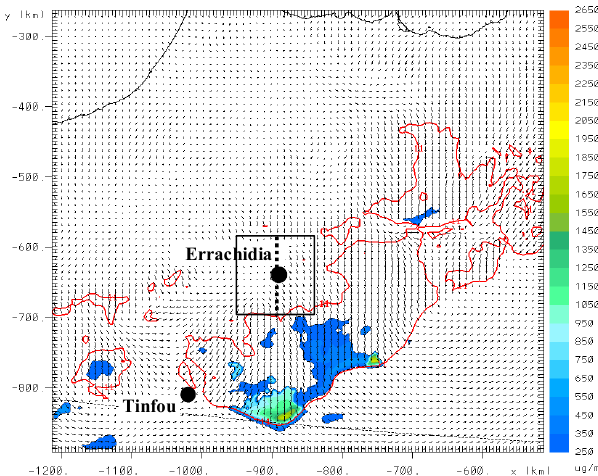
Fig. 4. Dust production (colored palette in µgm − 2 ) and wind ar- rows over the second (2.4 × 2.4km) model grid at 19:00 UTC on 31 May 2006. The red line represents the isotach of 11ms − 1 . The black rectangular shows the location of the third grid and the verti- cal dashed line indicates the location of the cross sections of Fig.